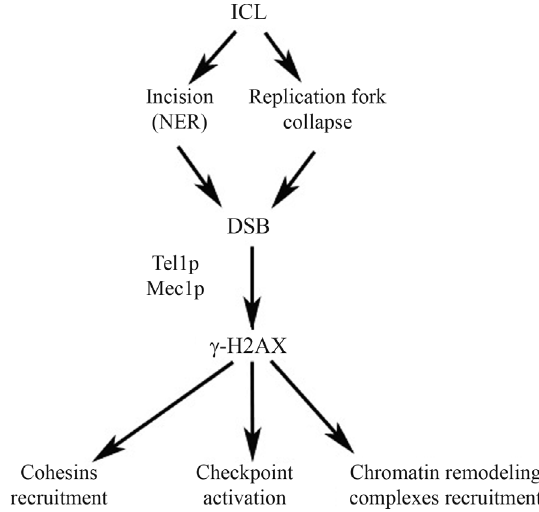
Figure 2 - DSB formation and (cid:8) -H2AX signaling following ICL forma-